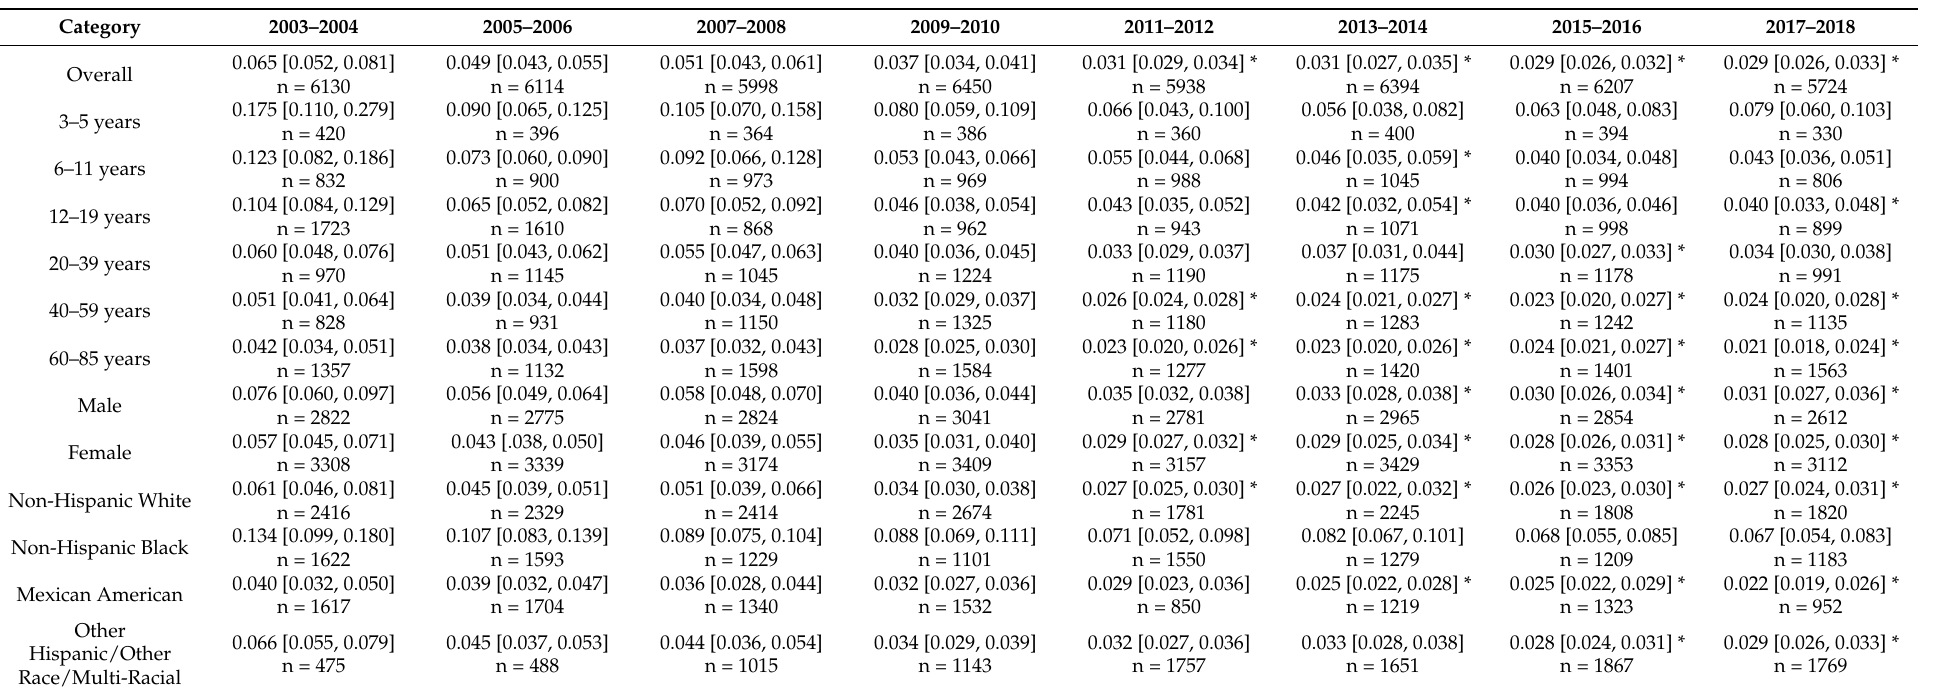
Table 1. Sample-weighted geometric means (GMs) [and 95% confidence intervals (CIs)] for serum cotinine concentrations in U.S. nonsmoker populations from 2003 to 2018. The number of study participants is also listed by group and survey period (n).